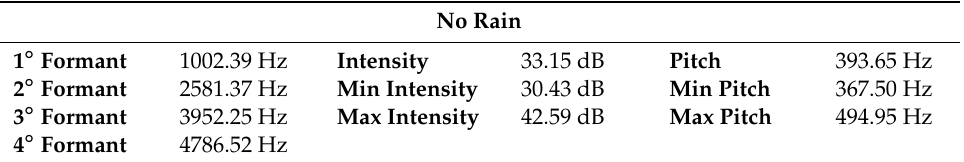
Table 3. Formants, intensity and pitch parameters of “No rain” audio